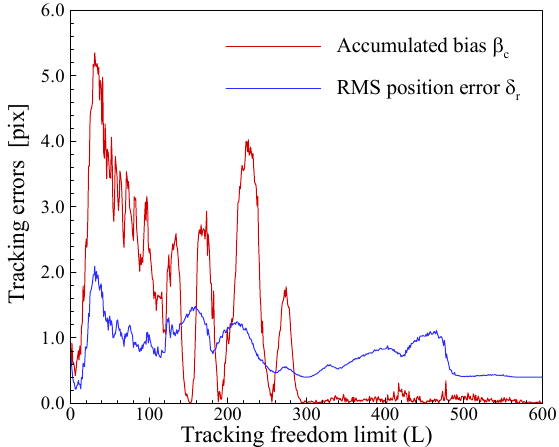
Fig. 5 indicates that in the current test case the RMS position error  pixels) between L= 1 and L=20, and it rise up to the highest peak of more than 2 pixels at L=30 .